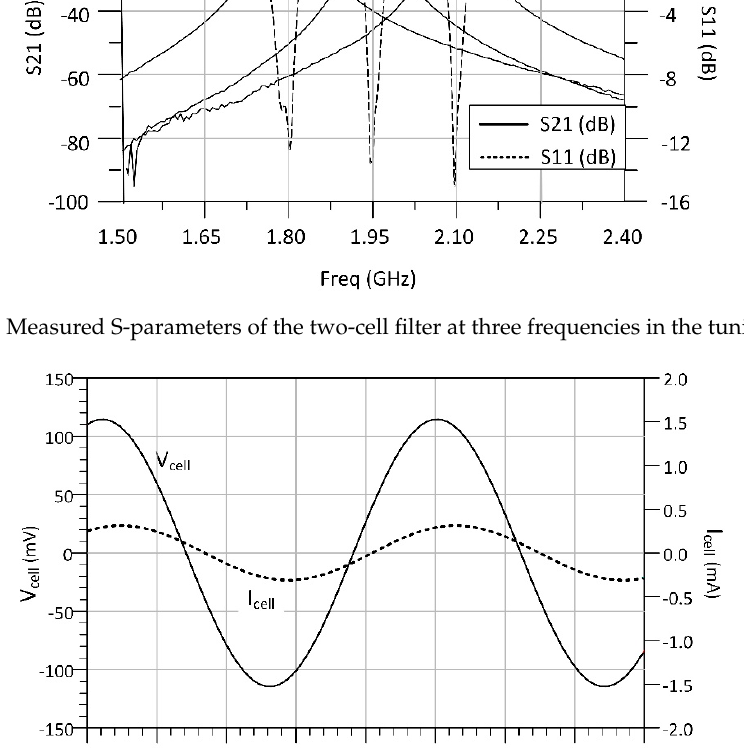
Figure 13. Simulated voltage and current at the input of the resonating cell (see Figure 10b).